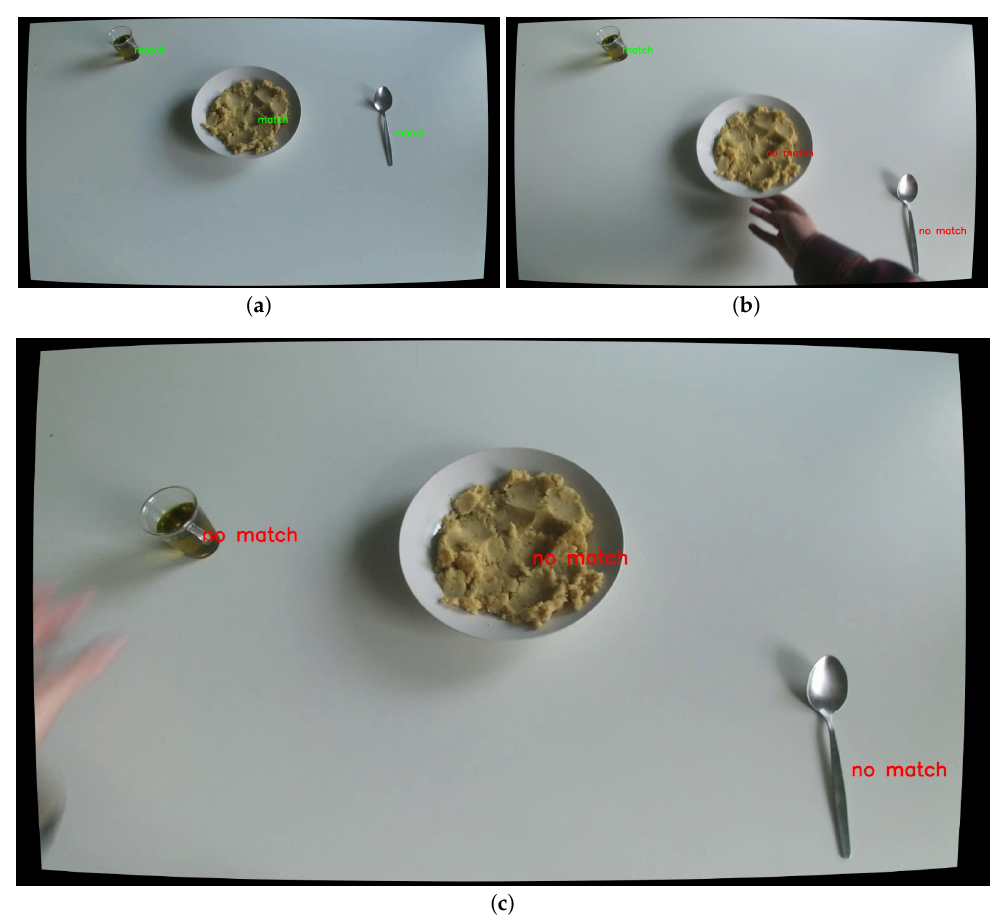
Figure 15. Assessment of the spatial configuration for “fava” recipe according to specifica- tion 2: ( a ) correct arrangement of objects, ( b ) some or all objects are not placed correctly, ( c ) objects are not placed